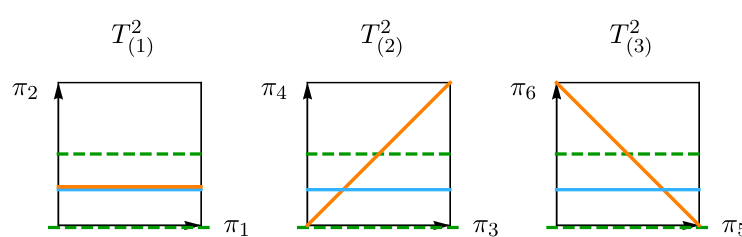
Figure 2 . D6-brane con(cid:12)gurations with codimension 5 intersection preserve a local N = 2 super- symmetry. The O6-planes are represented by the dashed, green